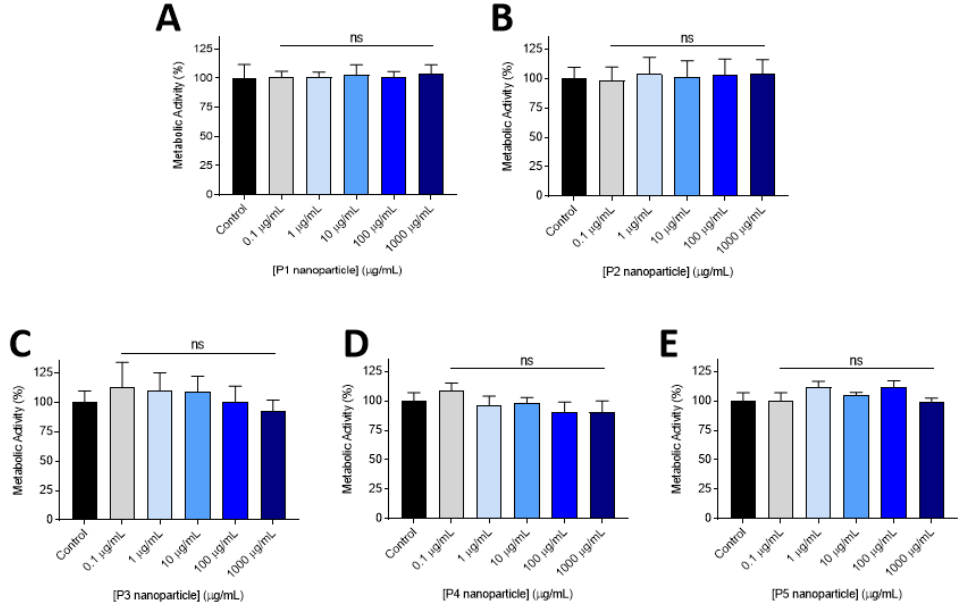
Figure 2. In vitro U87 cell viability assay at 72 h post-treatment with different concentrations of the five NP formulations P1